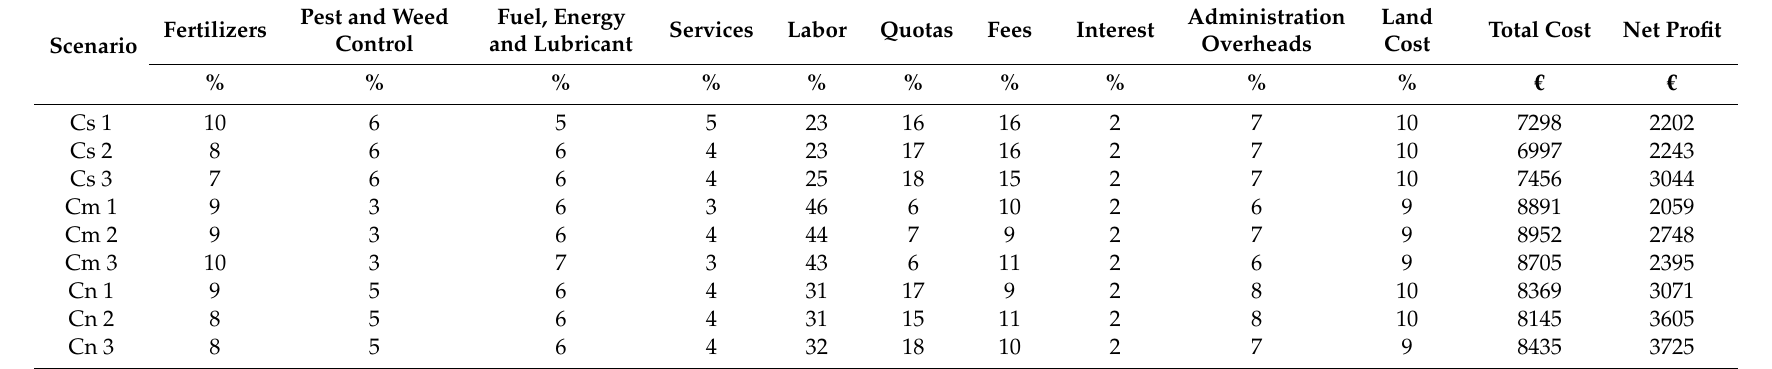
Table 8. Economic results in the conventional farming system (ha − 1 year − 1